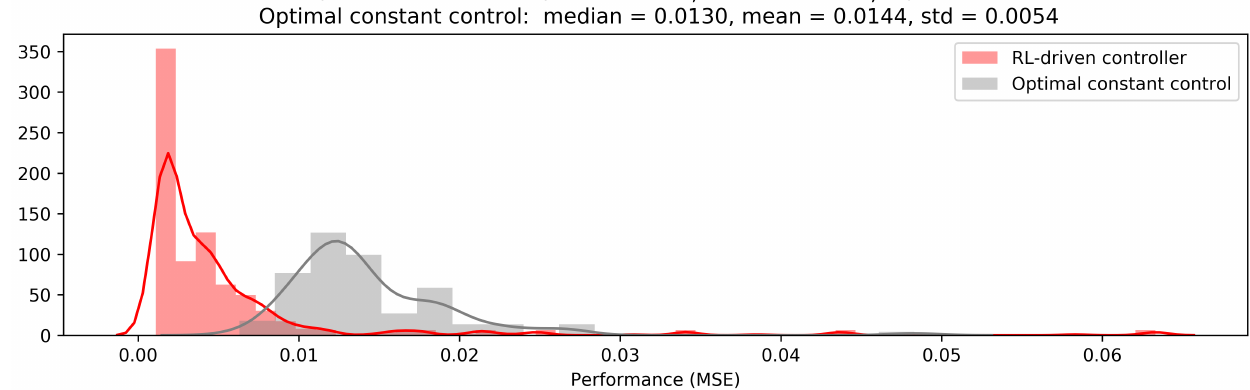
Figure 11. Performance metric (MSE) distribution for the developed RL controller and the competing approach (proportional control) for the 20 TCLs